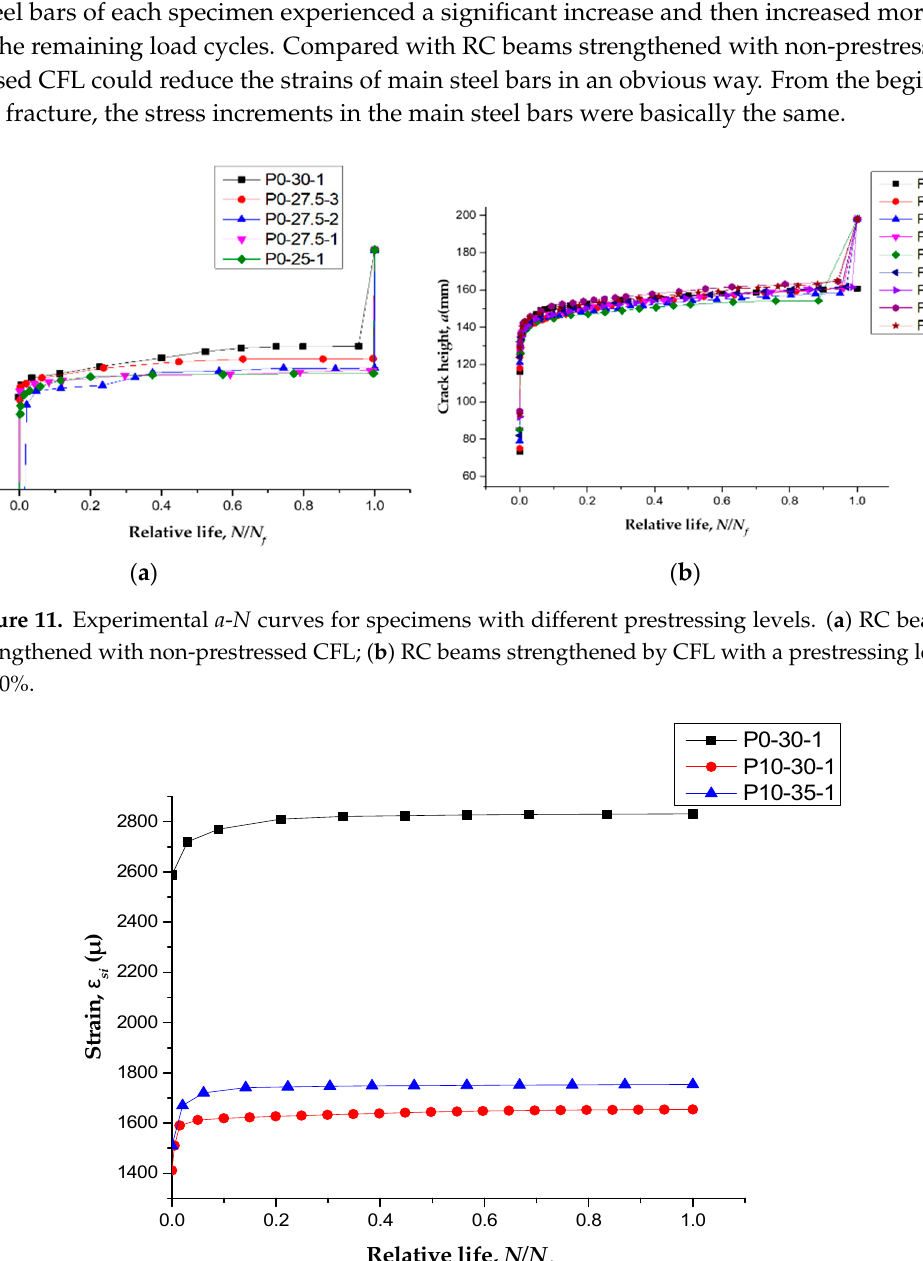
Figure 10. Crack pattern evolution at different loading cycles. ( a ) P0-30-1; ( b ) P10-40-2.